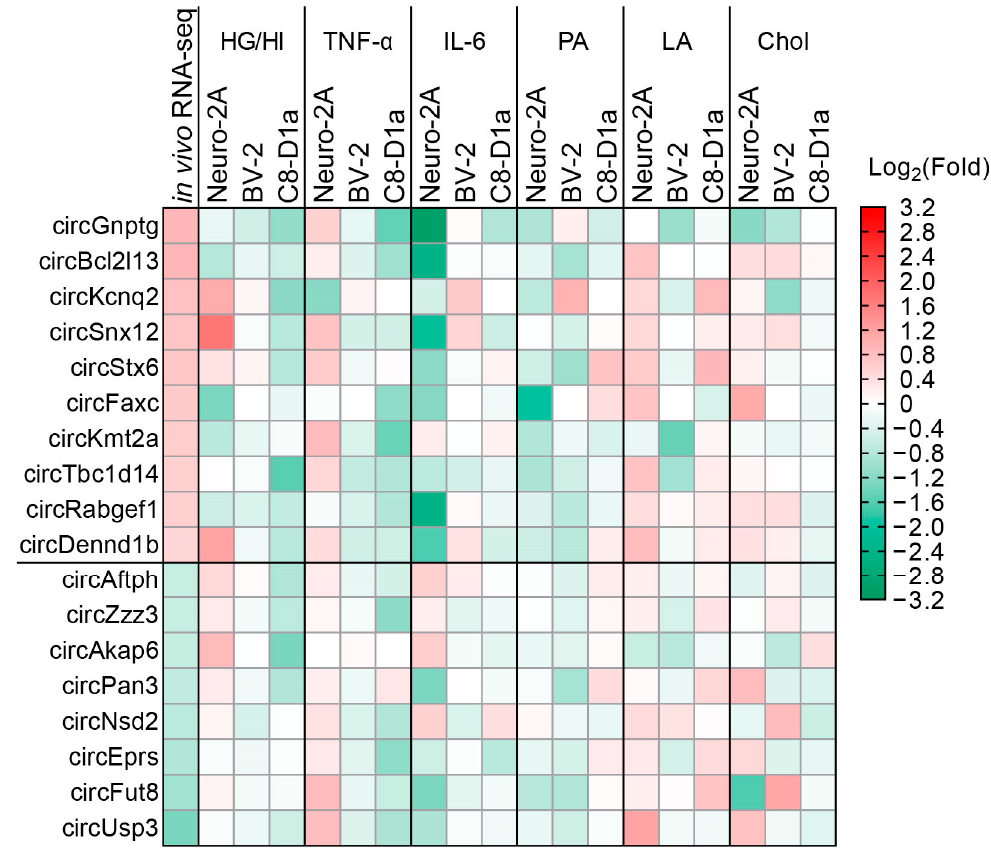
Figure 2. The heatmap displaying the differential expression of obesity-linked circRNAs in three mouse-brain cell lines under obesity-like conditions compared to normal controls. The data for in vivo RNA-seq were obtained and rearranged from our previous report about the transcriptomic analysis of the obese mouse-brain cortex (A reference is referred to in the manuscript). The data are expressed as the average Log 2 fold change (in vivo RNA-seq: n = 4, three cell lines: n = 3). The data value and cropped bands corresponding to the heatmap are provided in Supplementary Figures